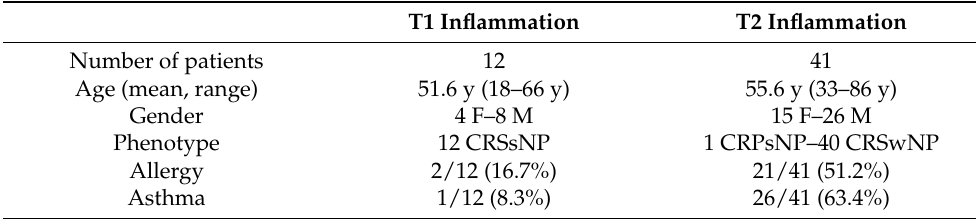
Table 1. Characteristics of patients included in the first experiment.